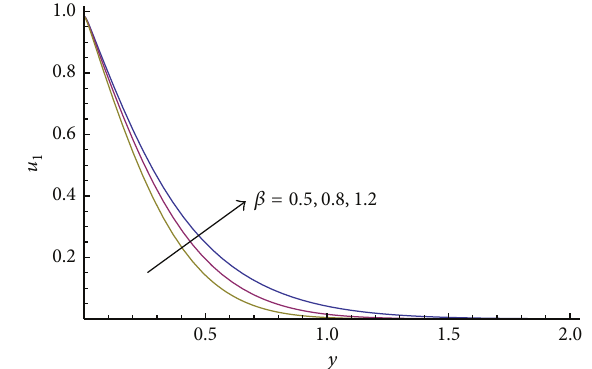
Figure 3: The influence of the fractional-order parameter 𝛽 on the velocity profile 𝑢 1 (𝑦,𝑧, 𝑡) with 𝑧 = 0.5 , 𝑡 = 0.3 , 𝛼 = 2 , Re = 1 , 𝜆 1 = 5 , = 2 , and 𝜆 = 1 𝜆 2 3